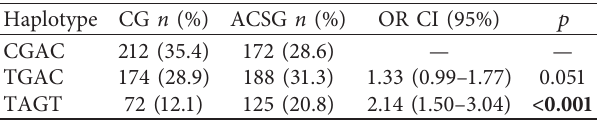
Table 5: Haplotype analysis of the rs1469513, rs673548, rs676210, and rs1042034 in the APOB gene in CG and ACSG.